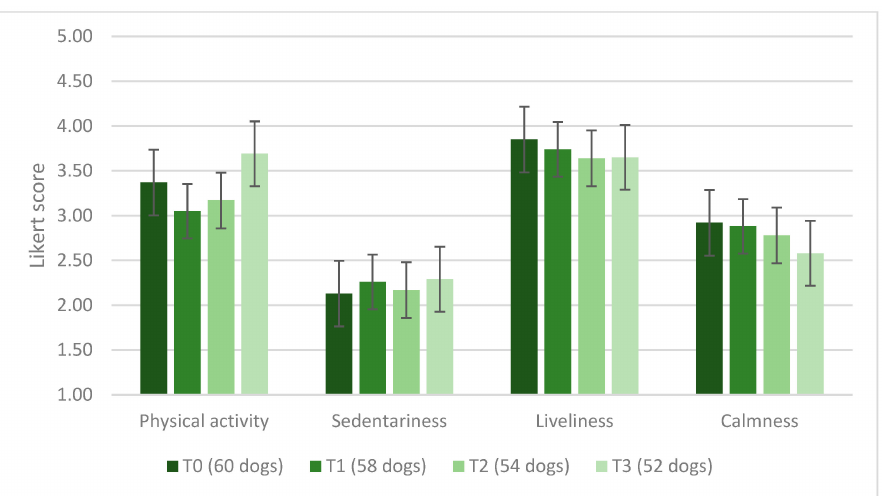
Figure 3. Average score on a Likert scale from 1, equal to “not at all”, to 5, equal to “very”, assigned by the owners evaluating the degree of physical activity, sedentariness, liveliness, and calmness of their